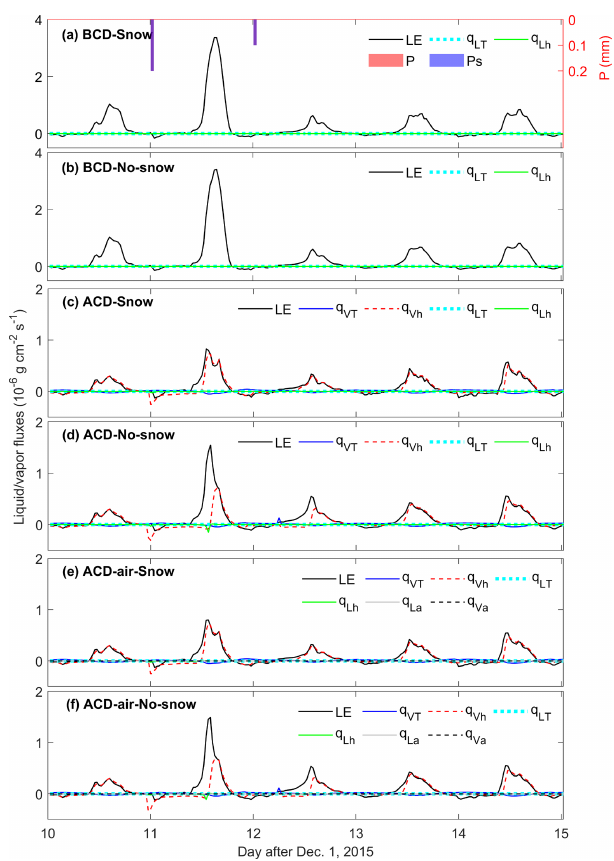
Figure 8. Model-simulated latent heat flux and surface soil (0.1cm) thermal and isothermal liquid water and vapor fluxes ( LE , q VT , q Vh , q LT , q Lh , q La , q Va ) with and without the snow module of a typi- cal 5d freezing period (from the 10th to 14th day after 1 Decem- ber 2015). Panels (a) , (c) , and (e) are the surface soil thermal and isothermal liquid water and vapor fluxes simulated by the BCD- Snow, ACD-Snow, and ACD-air-Snow models, respectively. Panels (b) , (d) , and (f) are the surface soil thermal and isothermal liquid water and vapor fluxes simulated by the BCD-No-Snow, ACD-No- Snow, and ACD-air-No-Snow models, respectively. LE is the latent heat flux, q VT and q Vh are the water vapor fluxes driven by temper- ature and matric potential gradients, respectively, q LT and q Lh are the liquid water fluxes driven by temperature and matric potential gradients, respectively, and q La and q Va are the liquid and vapor water fluxes driven by air pressure gradients, respectively. Positive and negative values indicate upward and downward fluxes, respec- tively. Note that the surface LE fluxes without snow sublimation are presented here. P is the precipitation, and Ps is the snowfall. All precipitation is in the form of snowfall.